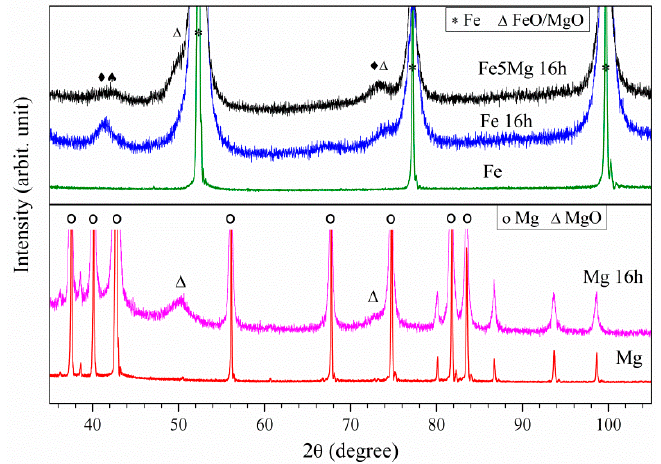
Figure 3. XRD of as-processed Fe5Mg16h, Fe16h, Fe, Mg16h, and Mg (arbitrary units). Table 1. Interplanar distances (ID, nm) corresponding to the [110] planes of α -Fe; and [ 112(cid:3364)0 ] and [0001] planes of Mg; and crystallite sizes (CS, nm).